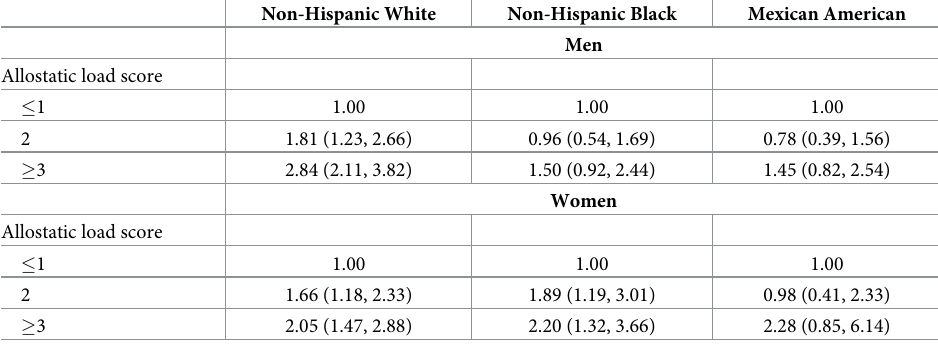
Table 7. Adjusted hazard ratios a of CVD-specific mortality risk for allostatic load score categories for racial/eth- nic groups according to sex: NHANES III-Linked Mortality File,